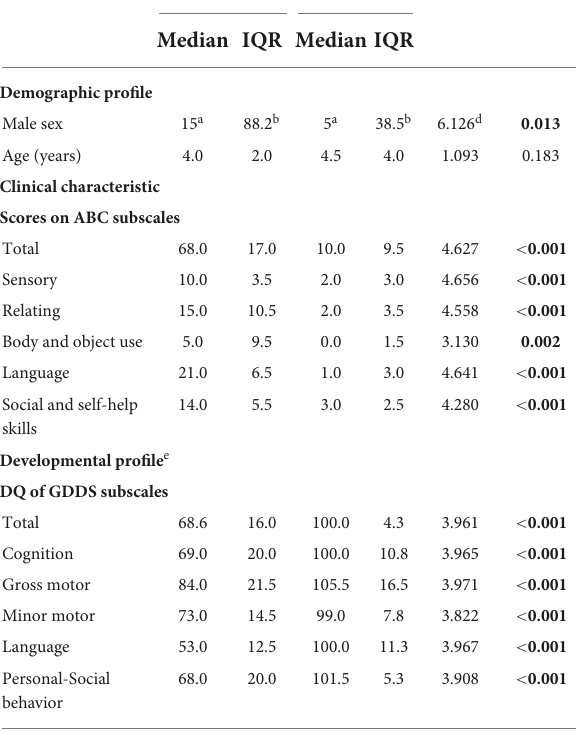
TABLE 1 Demographic and clinical characteristics of